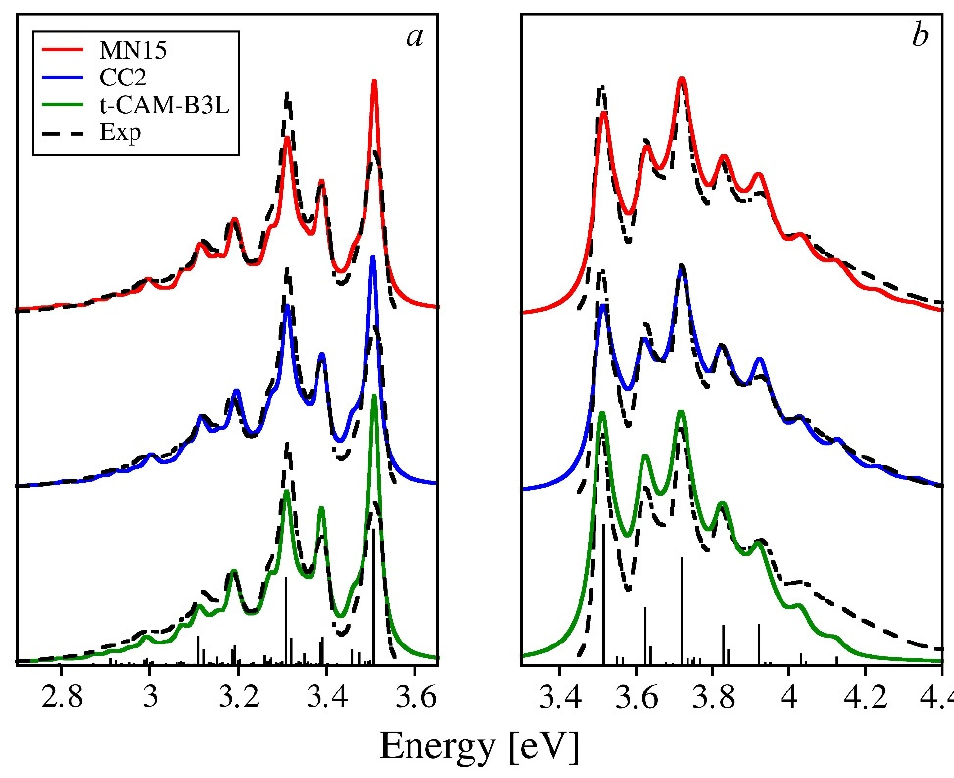
Figure 7. Emission ( a ) and absorption ( b ) spectra of 3O calculated using three theoretical methods selected in the previous section vs. the experimental spectrum by Seixas de Melo et al. [28]. The integral intensities of the theoretical spectra have been normalized to match the experiment. To ease the comparisons, the onsets of the computed spectra have been aligned to the experimental one. The stick spectrum has been obtained using the MN15